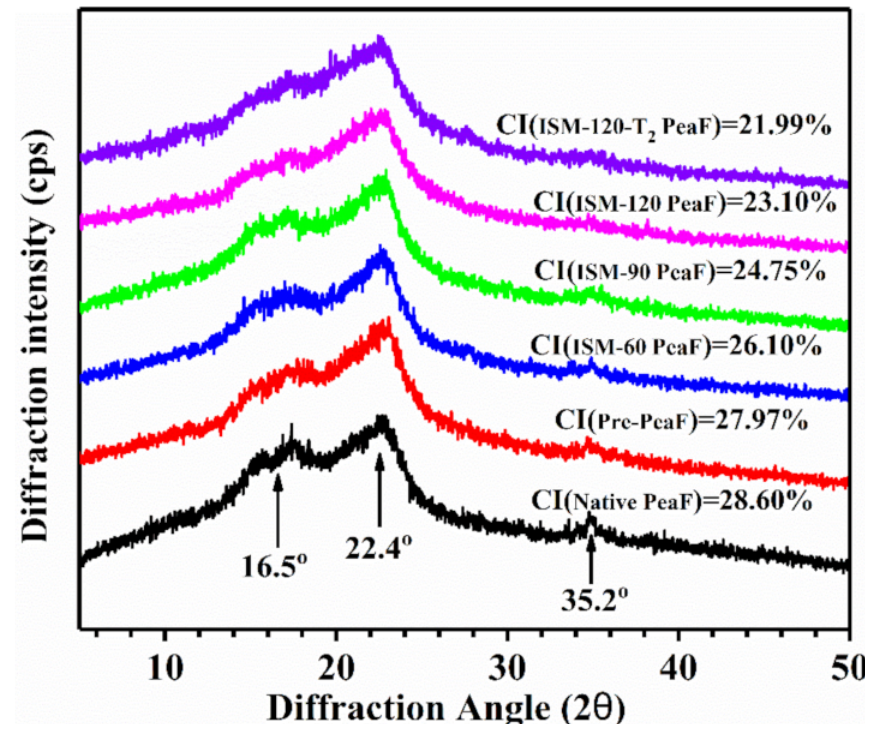
Figure 5. X-ray diffraction patterns of ISMS-treated